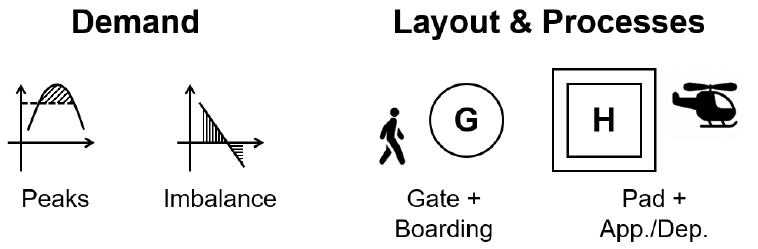
Figure 2. Depiction of design drivers for vertiport